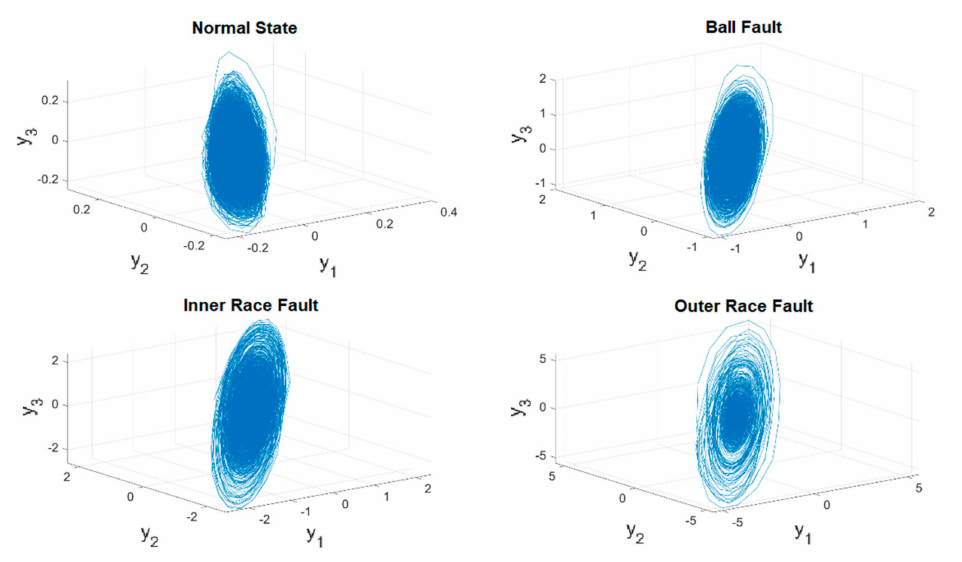
Figure 6. 3D phase portraits of original vibration data